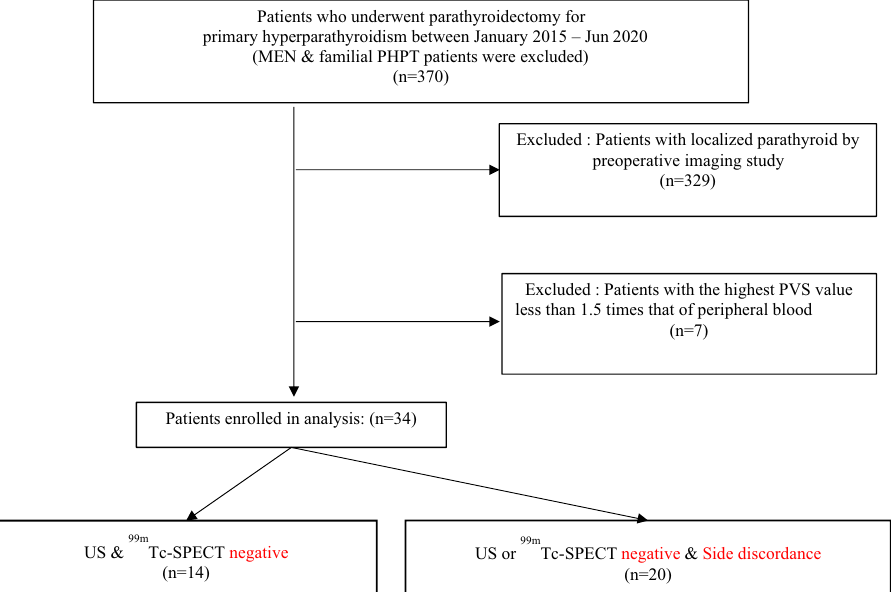
Figure 1. Flow-chart describing the inclusion of patients and the study population; MEN: Multiple endocrine neoplasia, PHPT: primary hyperparathyroidism, PTH: parathyroid hormone, PVS: parathyroid venous sampling, US: ultrasonography, SPECT: single-photon emission computed